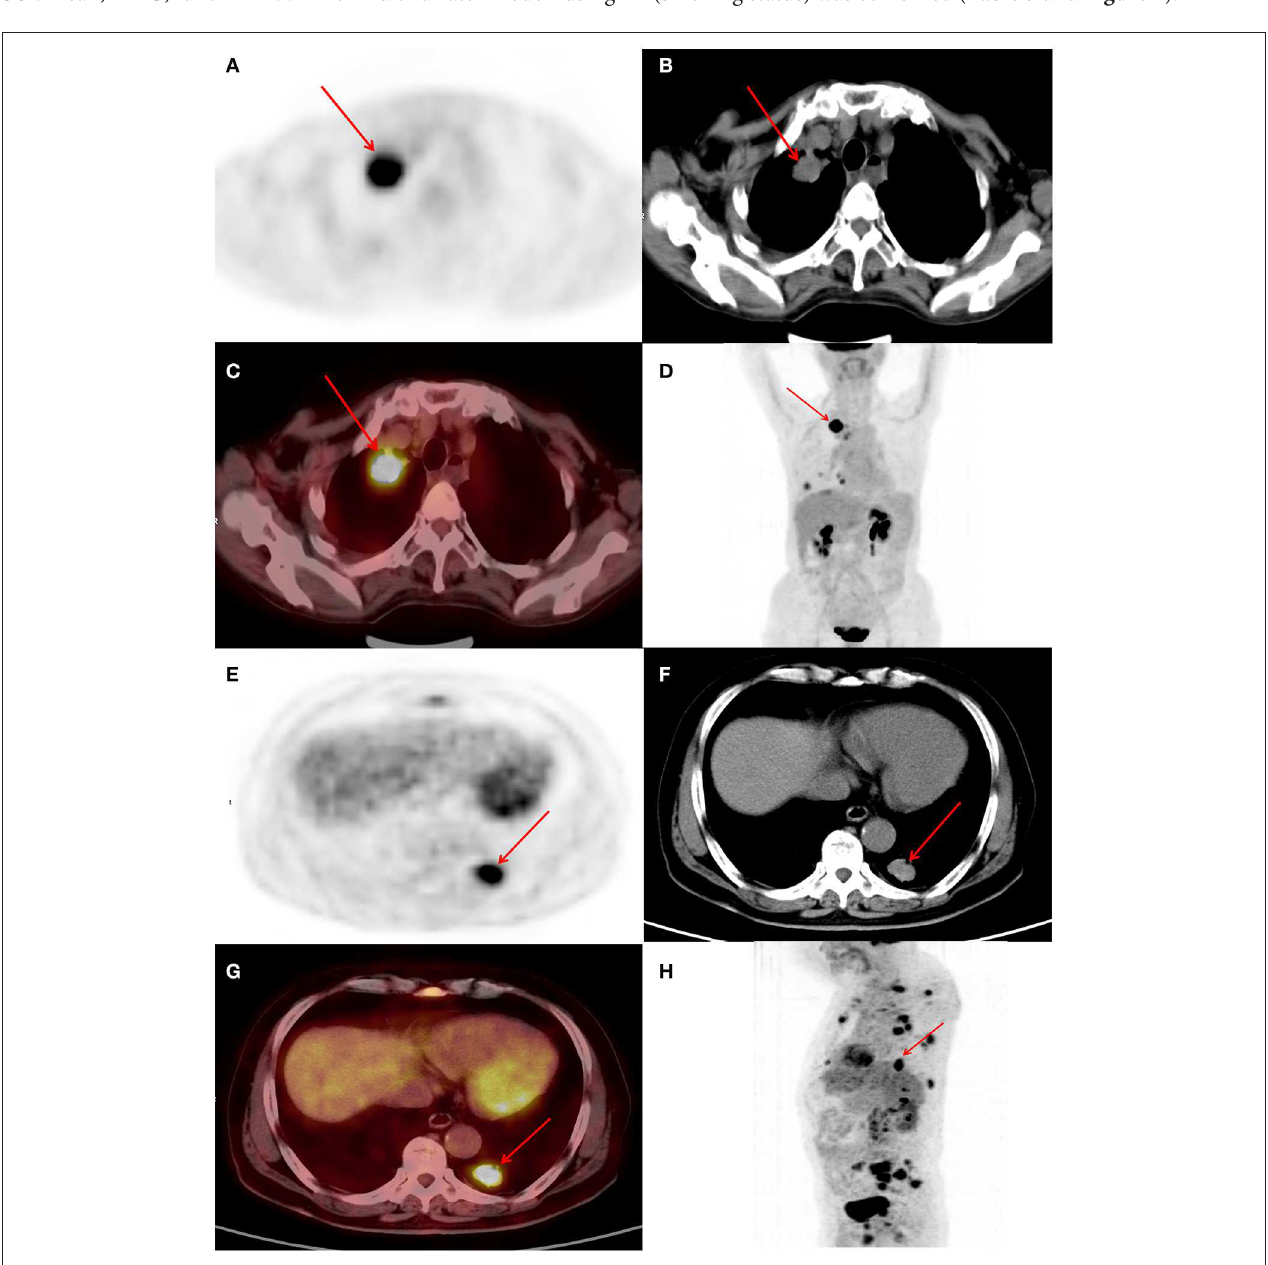
FIGURE 1 | (A–D) Female, 63 years of age. Positron emission tomography/computed tomography (PET/CT) revealing lung adenocarcinoma of the right upper lobe, ∼ 33 × 25mm, increased fluorodeoxyglucose (FDG) metabolism, maximum standardized uptake value (SUVmax) 6.8, epidermal growth factor ( EGFR ) mutation, and overall survival (OS) of 29 months. (E–H) Male, 72 years of age. Positron emission tomography/computed tomography (PET/CT) revealing lung adenocarcinoma of the posterior basal segment of the left lower lobe, ∼ 27 × 19mm, increased fluorodeoxyglucose (FDG) metabolism, maximum standardized uptake value (SUVmax) 9.4, epidermal growth factor receptor ( EGFR ) mutation, and OS of 13